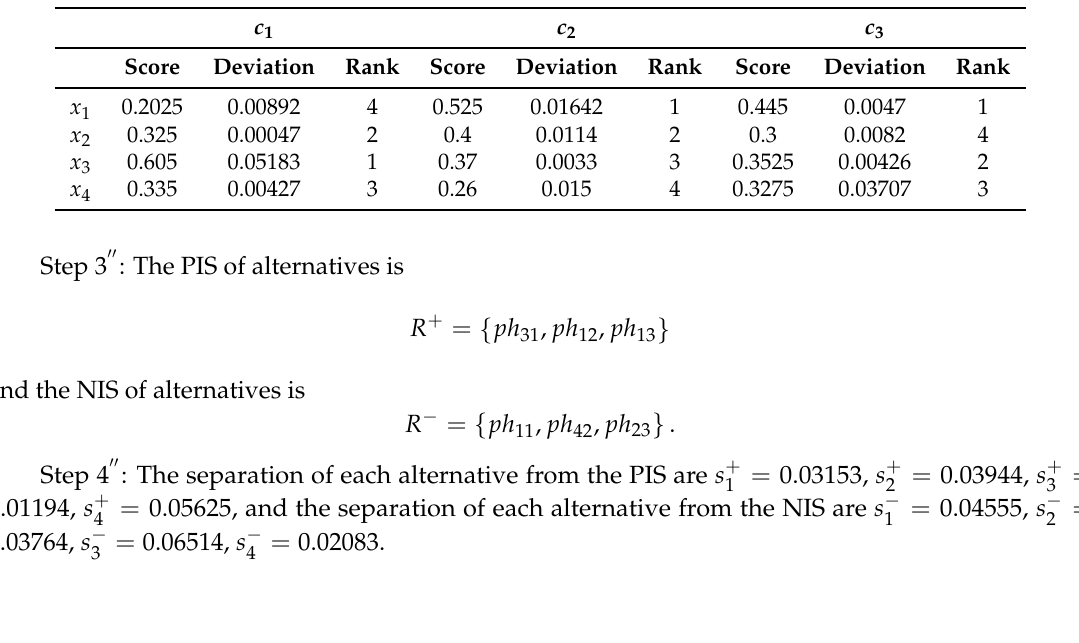
Table 14. Score and deviation values of PHFEs in matrix R